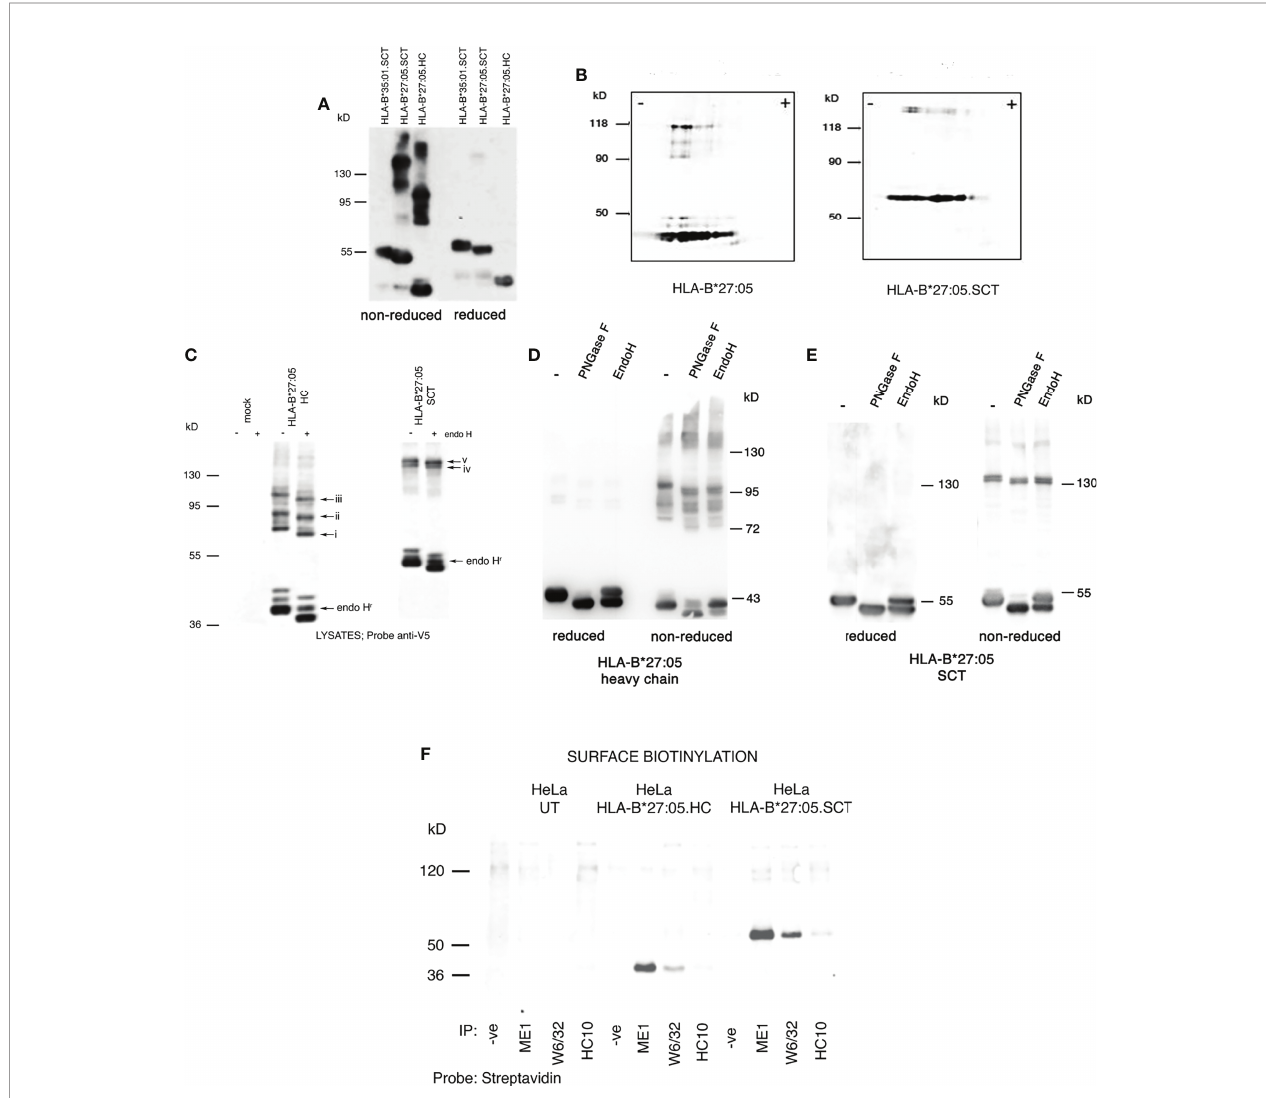
FIGURE 2 | HLA-B*27:05.SCT form predominantly ER resident and HC dimeric structures; (A) Immunoblotting for MHC class I heavy chain with anti-V5 antibody of cell lysates from HLA-B*27:05 SCT, HLA-B*27:05 HC and HLA-B*35:01.SCT expressing cell lines, resolved by non-reducing SDS-PAGE, reveals that HLA-B*27:05 SCT can form dimeric complexes. (B) Immunoblotting for MHC class I heavy chain with anti-V5 antibody of non-reduced cell lysates from HLA-B*27:05 SCT and HLA-B*27:05 HC expressing cell lines, resolved by two-dimensional isoelectric focusing gel electrophoresis, reveals the HLA-B27 signal resolved as monomers and dimers with identical pI. (C) Immunoblotting for MHC class I heavy chain with anti-V5 antibody of non-reduced cell lysates from HLA-B*27:05 SCT and HLA-B*27:05 HC expressing cell lines, following endoH digestion and resolved by non-reducing SDS-PAGE reveals that HLA-B*27:05.SCT and HC dimers exhibited endo H sensitivity and were therefore predominantly ER resident. Arrows i-iii indicate shift in Mw due to N-glycan removal from each of the distinct HLA-B*27:05 dimer conformers. Arrows iv-v indicate HLA-B*27.SCT dimers were endo H sensitive. Endo H resistant conformers of HLA-B*27:05 HC and SCT are highlighted by arrow endoH r . (D, E) Immunoblotting for MHC class I heavy chain with anti-V5 antibody of lysates from HLA-B*27:05.HC and SCT expressing cell lines, following PNGase F and endo H digestion, resolved by non-reducing and reducing SDS-PAGE reveals a signi fi cant proportion of HLA-B*27:05.HC and SCT molecules remain in an immature state as determined by sugar modi fi cations. Both HLA-B*27:05 HC and SCT high molecular weight complexes exhibit PNGase F and endo H sensitivity. (F) Immunoprecipitation with W6/32, ME1 and HC10 following cell surface biotinylation and resolution by non-reducing SDS-PAGE revealed no cell surface expression of HLA-B*27:05.SCT or HLA-B*27:05.HC